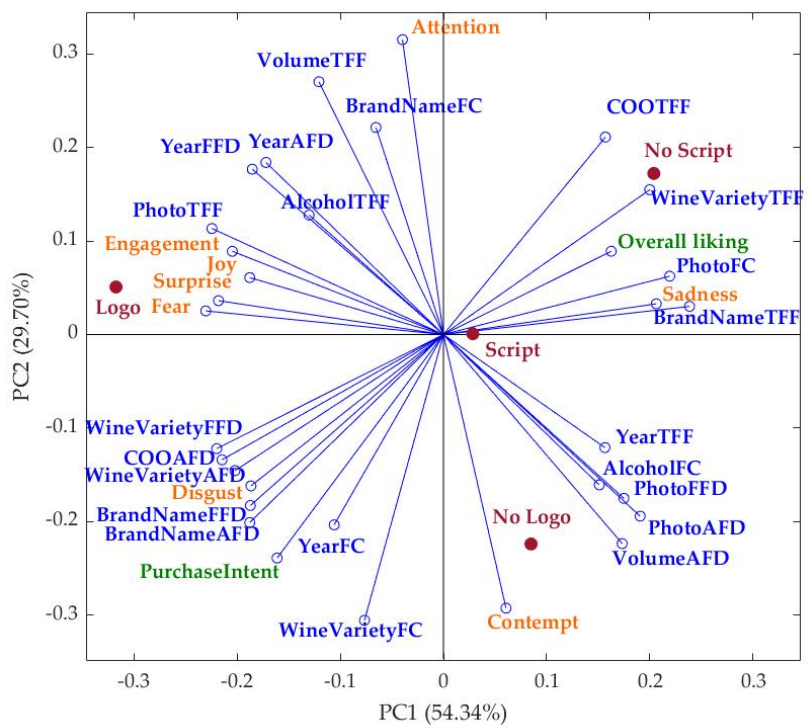
Figure 4. Principal component analysis (PCA) of the biometrics and self-reported responses obtained from study 1 for wine labels. Variables in blue belong to the eye-tracking measurements, orange represents the emotional responses and green represents self-reported responses. Abbreviations: PC: principal component; COO: country of origin; FC: fixation count; TFF: time to the first fixation; FFD: first fixation duration; AFD: average fixation duration.